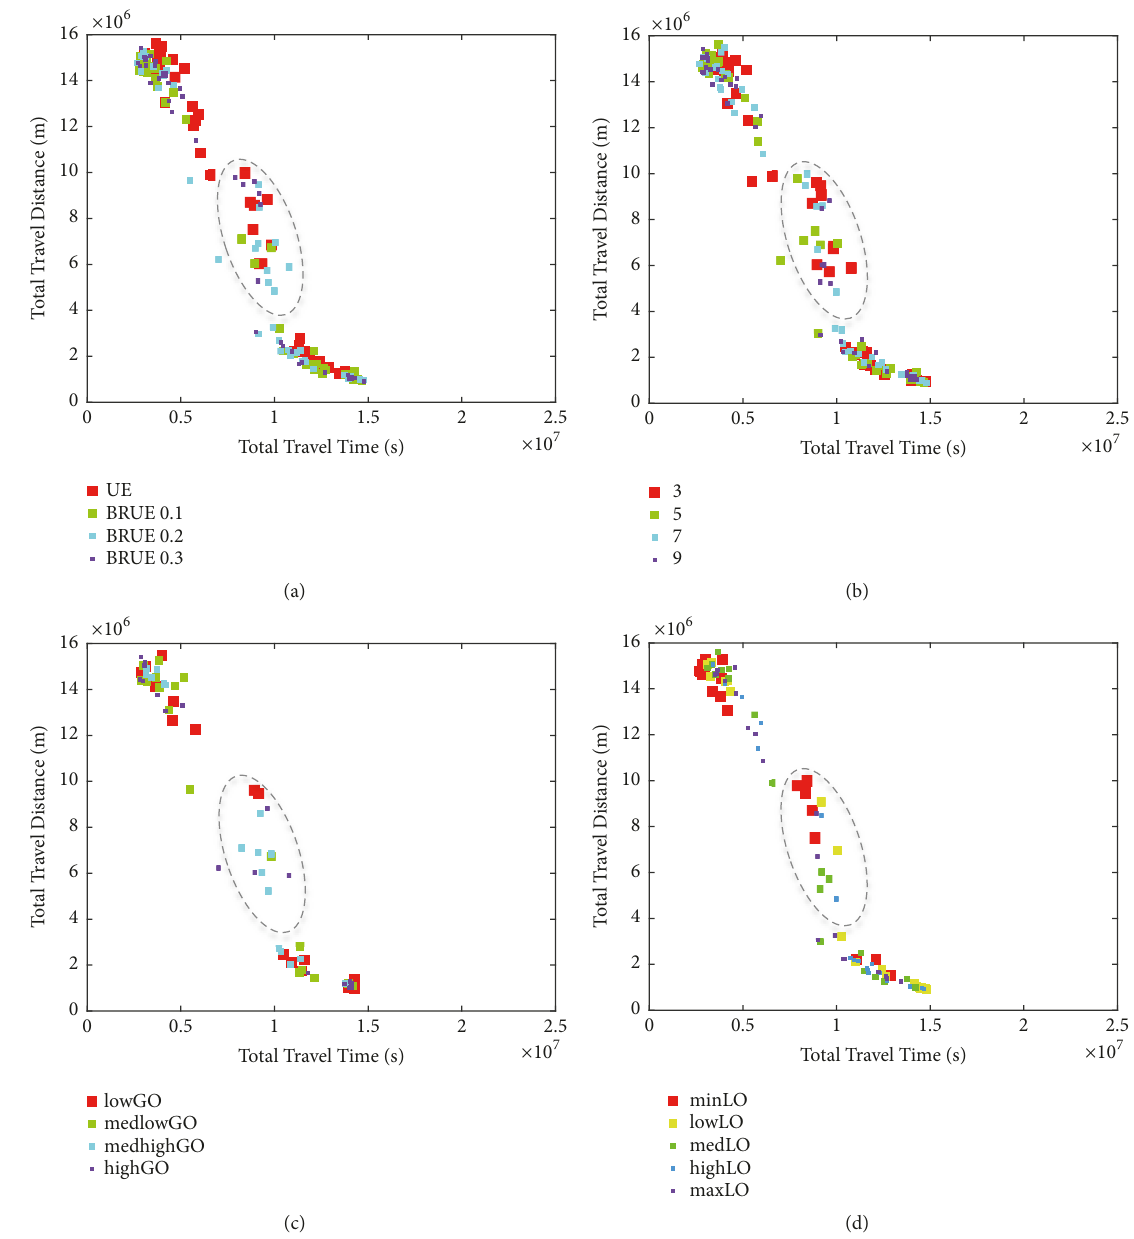
Figure 6: Final network states with demand level 4, colored by (a) equilibrium criterion, (b) number of paths per OD, (c) global overlapping level, or (d) local overlapping